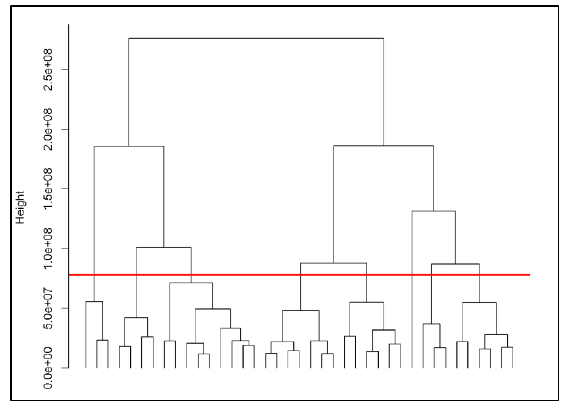
Figure 5. The hierarchical clustering tree and the cut line (red).